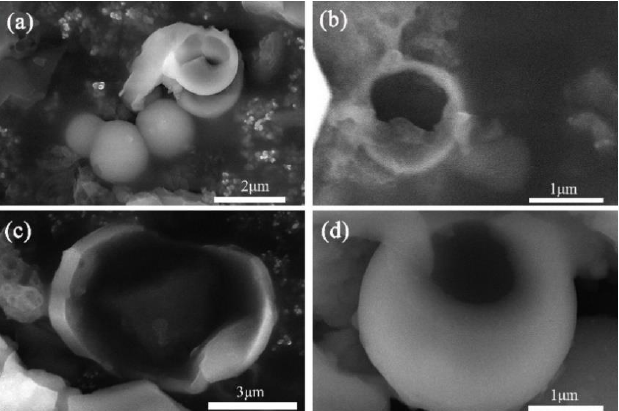
Figure 5. SEM micrographs of the deliberately damaged broken ( a , b ) paraffin@SiO 2 microcapsules, ( c , d ) the paraffin@SiO 2 colored microcapsules.